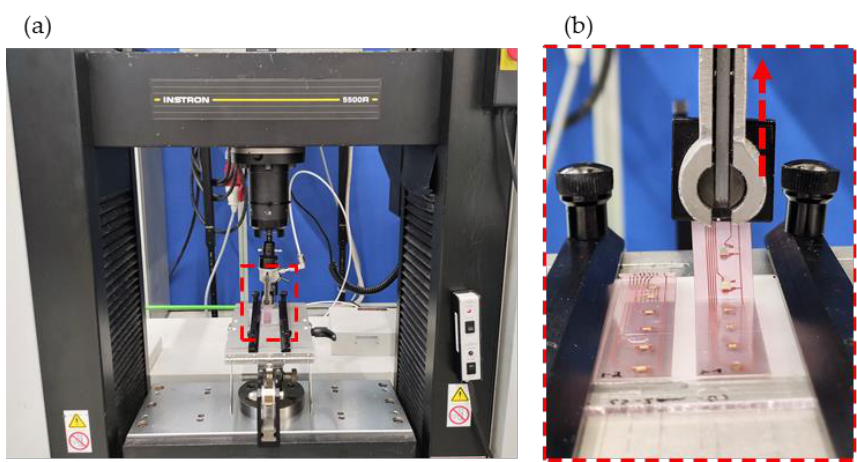
Figure 7. Strips of already overmolded foils with components were laser cut and fixed in a peel-off fixture ( a ) and peeled at an angle of 90° ( b ).